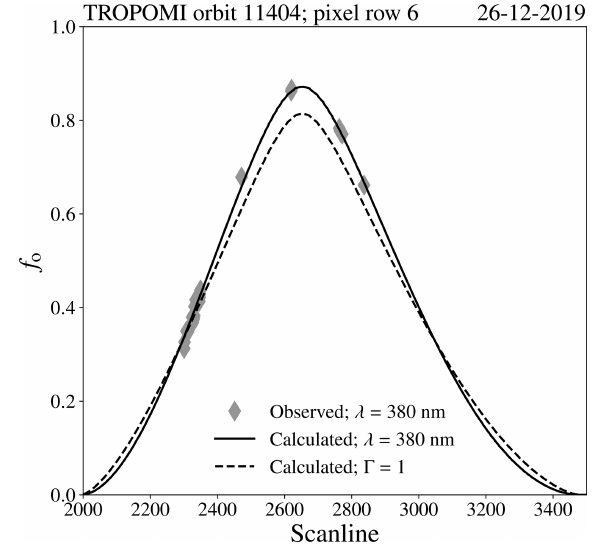
Figure 14. The observed eclipse obscuration fraction by TROPOMI in orbit 11404 on 26 December 2019 (grey diamond dots), com- pared to the calculated eclipse obscuration fraction at 380nm in- cluding solar limb darkening (black solid line) and for (cid:48) = 1 which excludes solar limb darkening (black dashed line), per scan line in pixel row